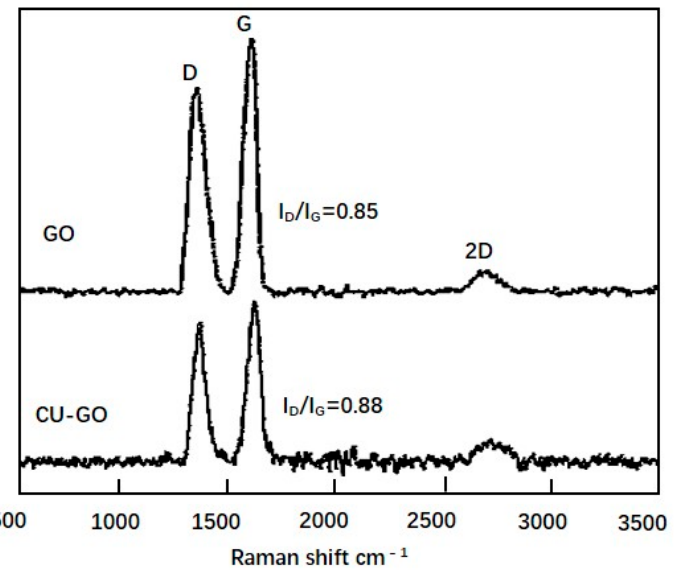
Figure 3. Comparison of Raman spectra of graphene oxide (GO) powder and ball-milled Cu-GO composite powder.